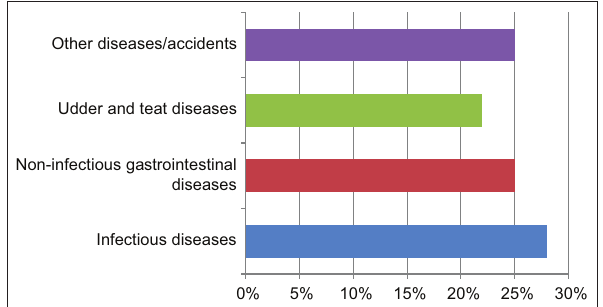
Figure-2: Major categories of mortality causes of adult dairy cows over a 3‑year period (2016−2018) in a single intensively managed dairy farm in Jordan (n = 88).